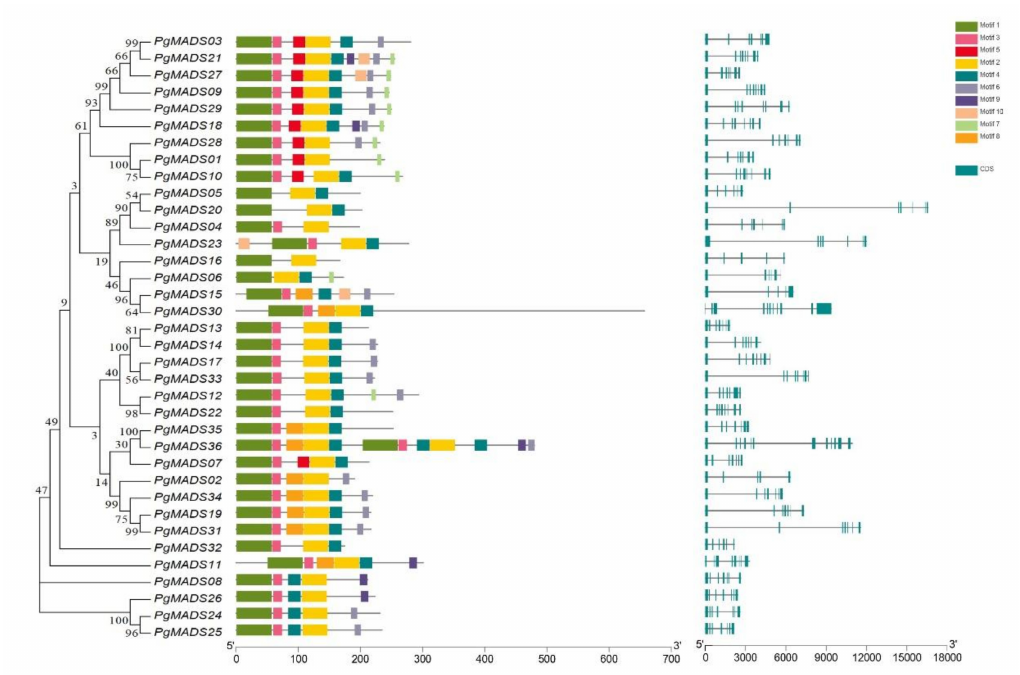
Figure 2. Phylogenetic tree, gene structure and conservative protein motifs of the MIKC-type MADS-box family in